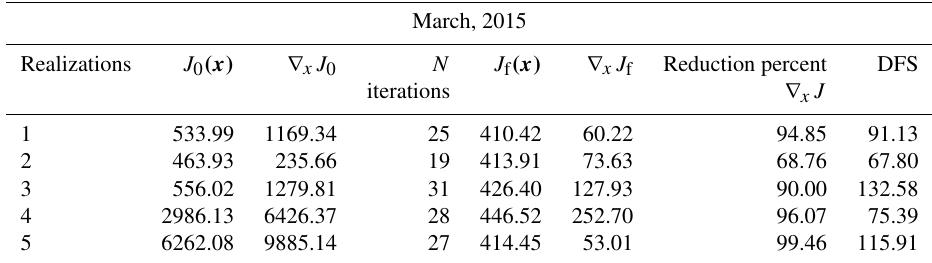
Table C3. Convergence diagnostic of sensitivity case (3) after the inversion using an ensemble of five independent OSSEs for March 2015 ( ∇ x J 0 and ∇ x J 0 represent the initial cost function and its gradient at the beginning of the optimization, and ∇ x J f and ∇ x J f represent them at the end of the